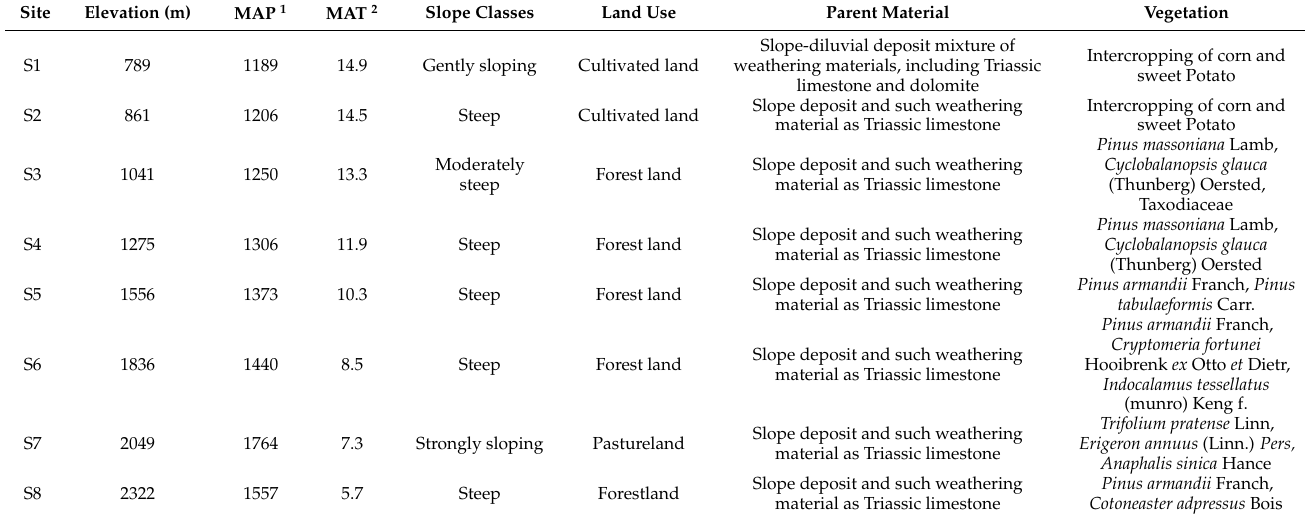
Table 1. Site characteristics for soils derived from carbonate rocks along a climosequence in a subtropical mountain, China.